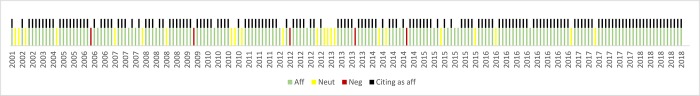
Reception of Wickström and Bendix 2000.